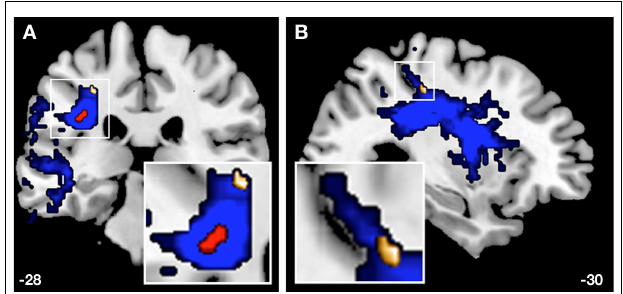
FIGURE 7 | A coronal (A) and a sagittal (B) view of the probability map of the APs’ left SLF are illustrated (blue). The red cluster represents the overlaid ROI ( Figure 3 ) due to the thresholded probability map ( p < 0.05), whereas the golden cluster (see also Figure 5B ) represents voxels of FA values ( − 28, − 28, 44) that are signifi cantly correlated ( r = 0.758**) with the error rates of APs with respect to the